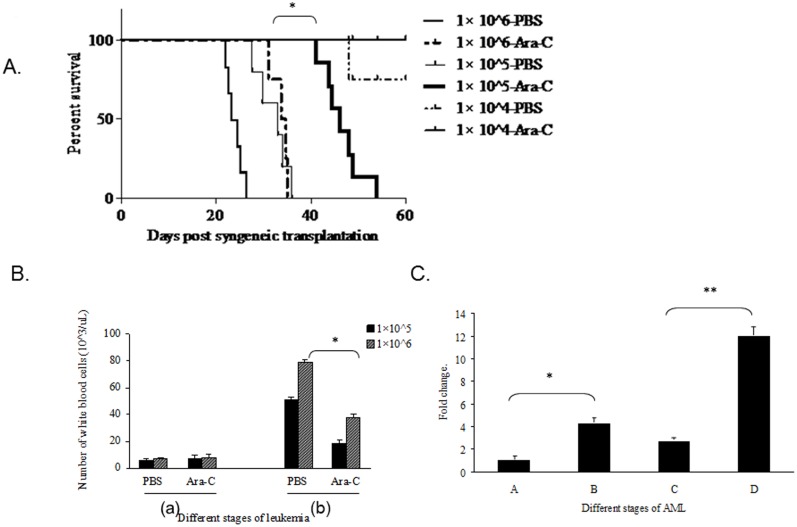
The effect of leukemic load on the survival of recipient mice.Fig. 3A) The survival of B6C3F1 mice receiving different dose of B117P cells and treated with either Ara-C or PBS. Each group included 12 mice. The mice were watched for 60 days. Fig. 3B) The white blood cell counts at different stages of transplanted leukemia in the mouse model. (a) before transplant, (b) after the first course of treatment. Fig. 3C) The abundance of B117 tag in the peripheral blood of recipient mice detected by q-PCR, taking β-actin as the reference, at different time points, (A) 2 days following the transplantation, (B) right before the treatment, (C) following the first course of treatment, (D) following the second course of treatment. *p<0.05, **p<0.01. The data were presented as mean +/− SD of triplicate.